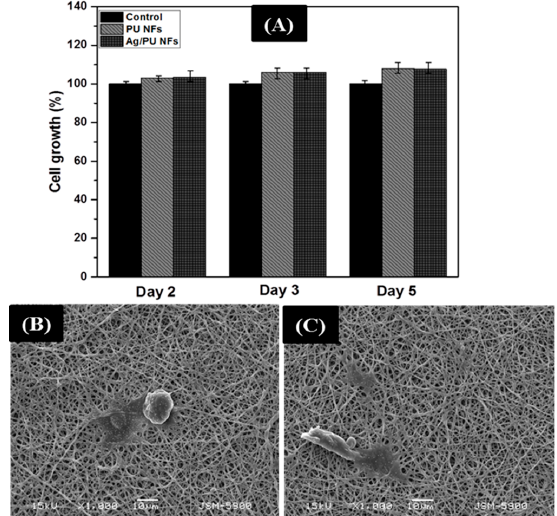
Figure 8. NIH-3T3 cell proliferation on various nanofiber membranes after culture for one, three, and five days ( A ). The viability of the control cells was set to 100% and the viability relative to the control was expressed. ( B ) and ( C ) represent the SEM images of the cell fixation test on the PU NFs and Ag/PU NFs after five days of incubation, respectively.